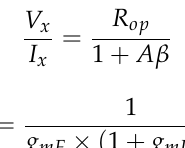
Figure 5. The block diagram of source followers: ( a ) conventional source follower; ( b ) super source follower; and ( c ) output impedance calculation circuit of the SSF.